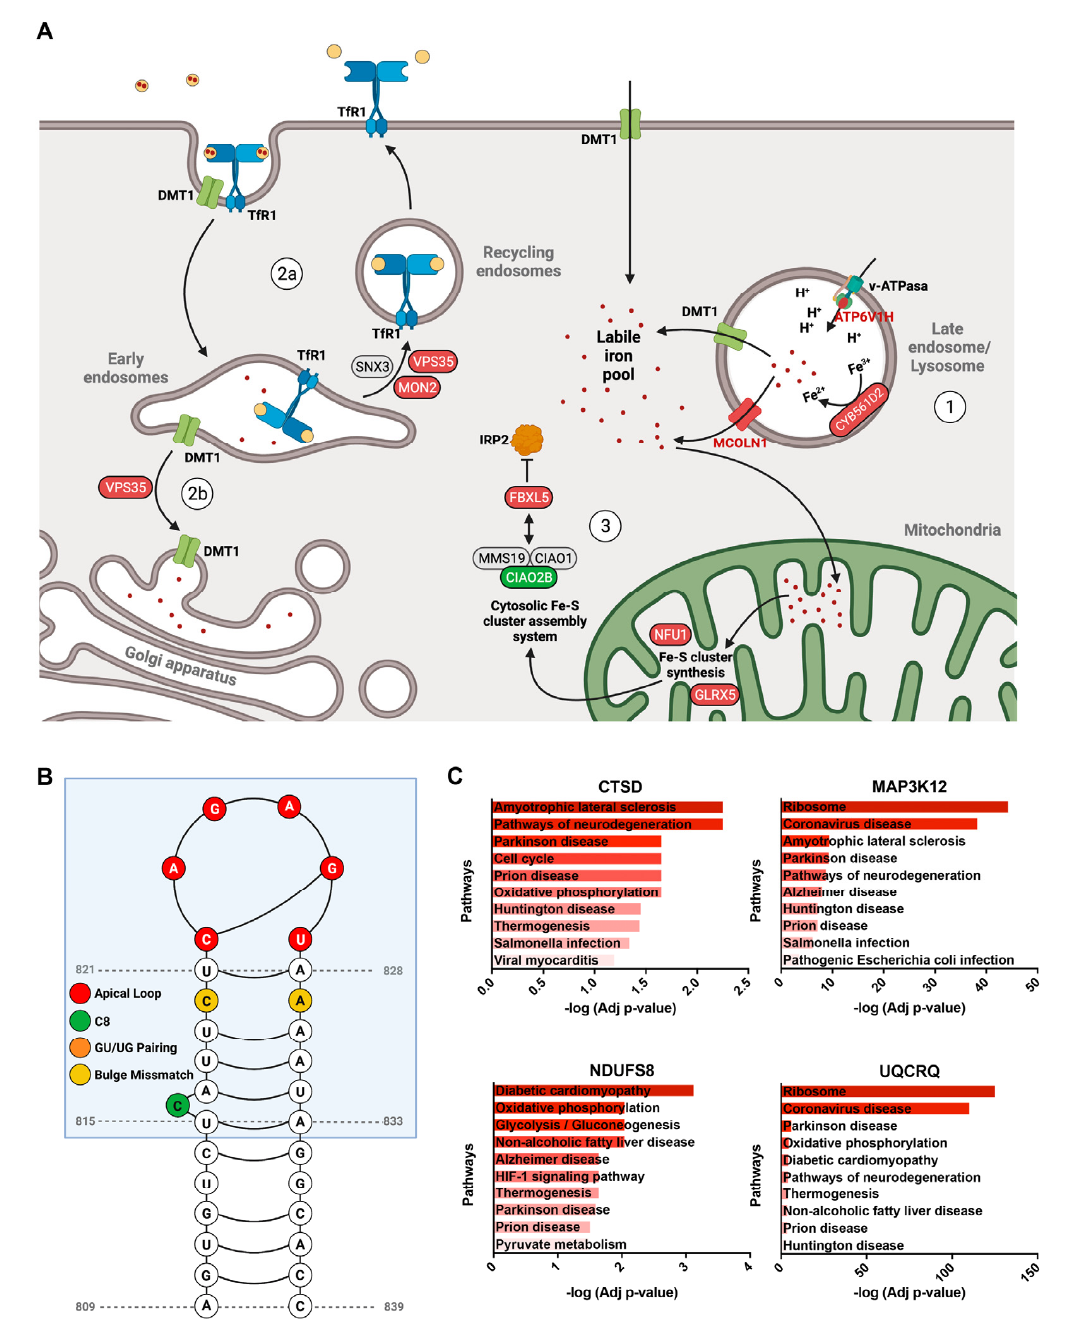
Figure 4. Poorly characterized proteins that contribute to upholding iron homeostasis in neurons. ( A ) Many CRISPRi-targeted genes associated with altered iron levels (increased in red, decreased in green) are connected to the key mechanisms of homeostatic control of this metal. These included lysosomal proteins responsible for iron exit from endolysosomal compartments (1); retromer com- plex subunits involved in TfR1 (2a) and DMT1 (2b) intracellular trafficking and proteins involved in the regulation of IRP2 levels (3). ( B ) The putative 2D structure of IRE localized in the mRNA of VHL. ( C ) KEGG pathways associated with DEG obtained from CRISPR-mediated genetic perturba- tions coupled to single-cell RNA sequencing identify a potential link between the genes involved in